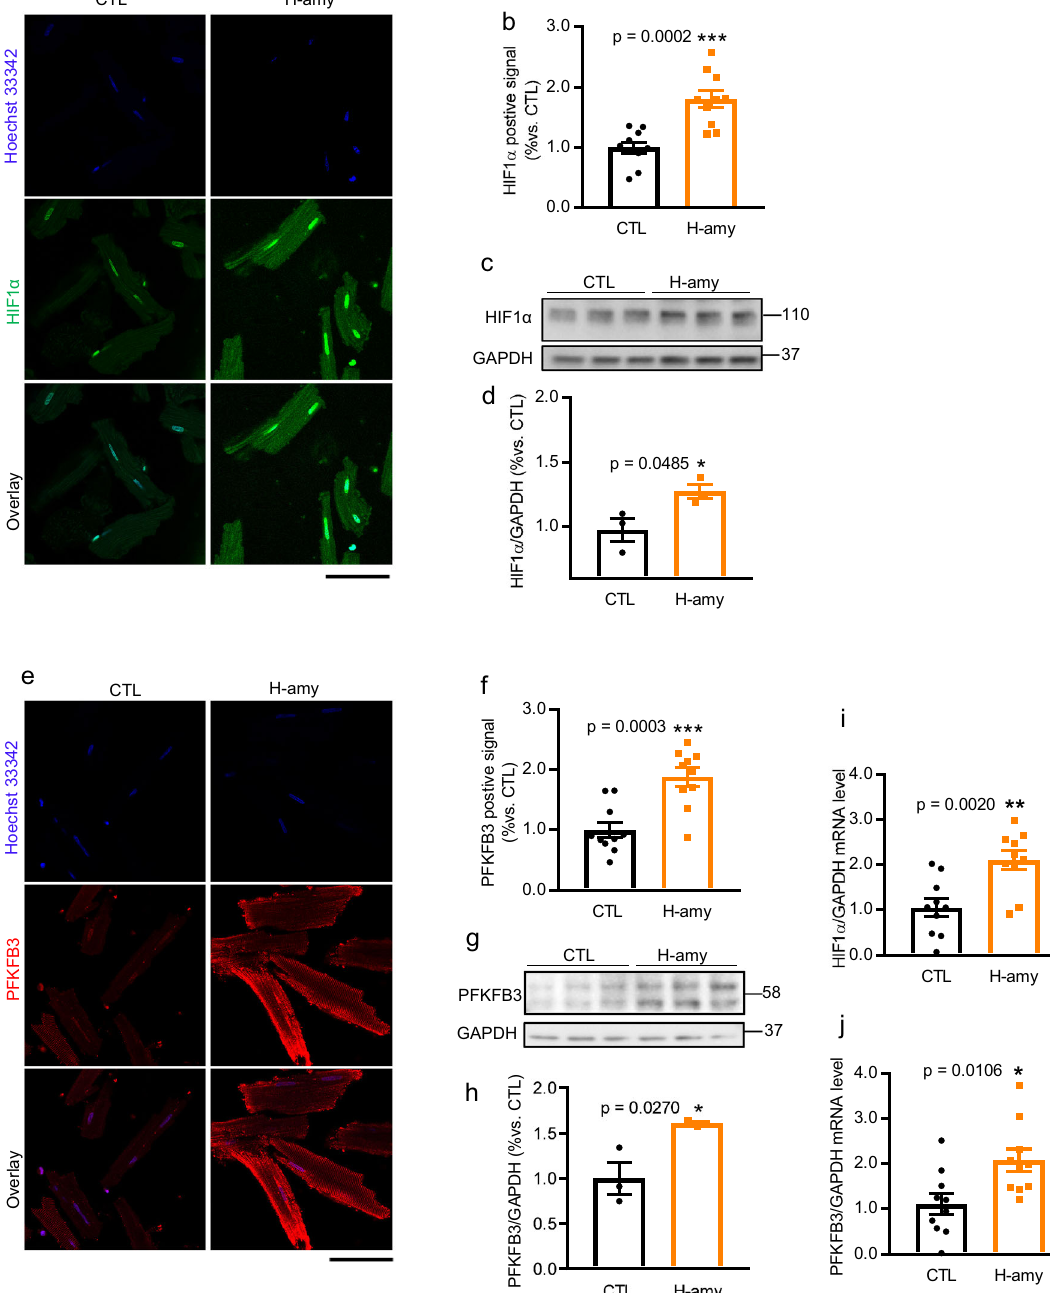
Fig. 7 Cardiac amylin accumulation activated HIF1 α and PFKFB3 in isolated RVCMs. a – j Increased expression of HIF1 α ( a – d , i ) and PFKFB3 ( e – h , j ) in RVCMs treated with or without H-amy for 2 h. a , b Immuno fl uorescence staining ( a , green color, mouse anti-HIF1 α antibody; blue color, Hoechst 33342) in cells treated under the above conditions and b quanti fi cation of HIF1 α positive signal was shown in bar graph ( n = 10/group). c , d Western blot analysis (blot, c and bar graph, d ) of HIF1 α (mouse anti-HIF1 α antibody) in RVCMs treated as in panel ( a ) ( n = 3/group). e , f Immuno fl uorescence staining ( e , red color, rabbit anti-PFKFB3 antibody; blue color, Hoechst 33342) in cells under the above conditions and f quanti fi cation of PFKFB3 positive signal was shown in bar graph ( n = 10/group). g , h Western blot analysis (blot, g and bar graph, h ) of PFKFB3 (rabbit anti-PFKFB3 antibody) in RVCMs treated as in panel ( a ) ( n = 3/group). i , j Increased mRNA levels of HIF1 α ( i ) and PFKFB3 ( j ) in RVCMs incubated with amylin ( n = 10/group). Scale bar, 100 µ m. Data represent mean ± SEM. * P < 0.05, ** P < 0.01, *** P < 0.001 by Student ’ s t